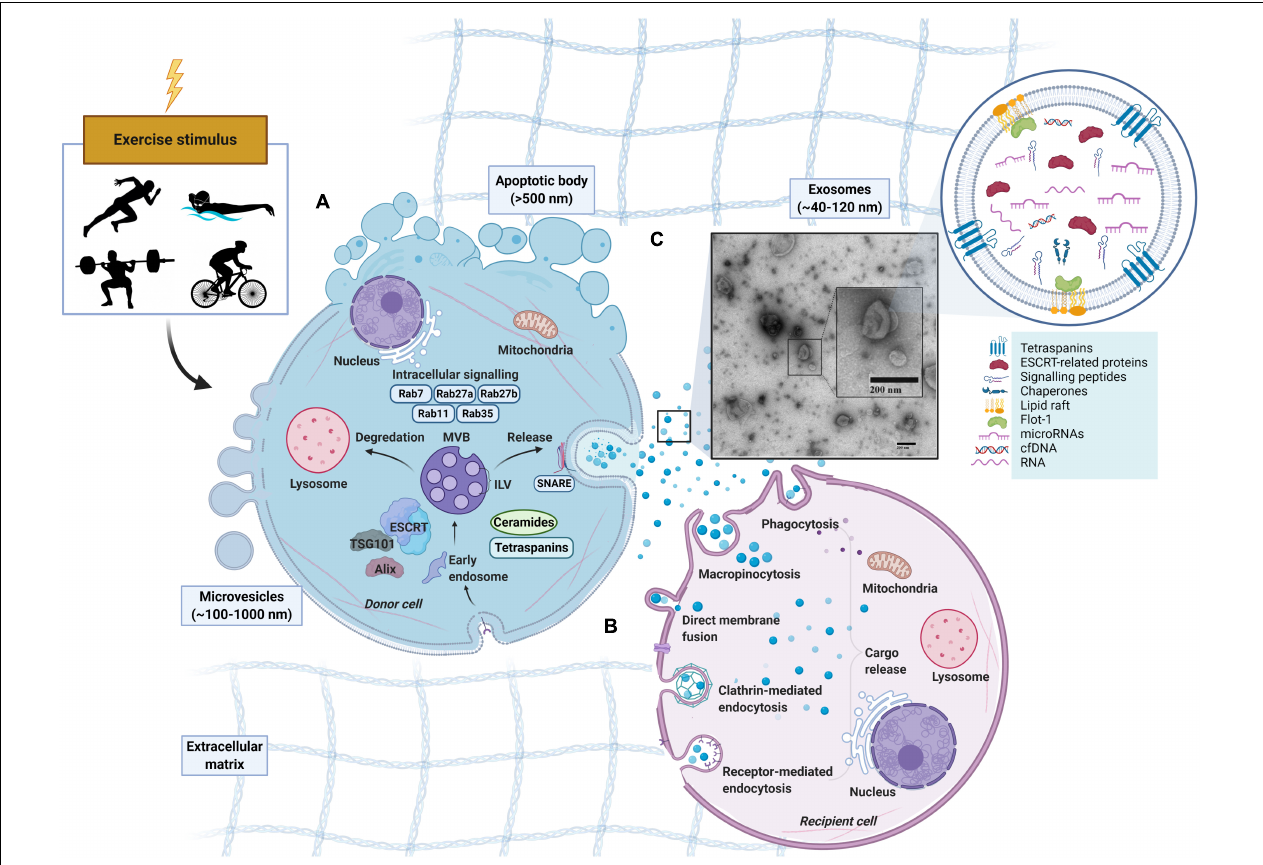
FIGURE 1 | Schematic representation of extracellular vesicles released by cells in response to exercise. Apoptotic bodies ( ∼ > 500 nm), microvesicles ( ∼ 100–1,000 nm) and exosomes ( ∼ 40–120 nm). (A) Exosome formation. Early endosomes form from the inward budding of the plasma membrane (PM) before maturing into late endosomes which contain multiple intraluminal vesicles (ILVs). With the presence of ILVs, the late endosome can also be characterized as a multivesicular body (MVB) (Sotelo and Porter, 1959; Akers et al., 2013). MVBs exist in different subpopulations (White et al., 2006) can either fuse with a lysosome for degradation, or fuse with the PM to release ILVs into the extracellular space as exosomes (Akers et al., 2013; Crenshaw et al., 2018). MVB development in an Endosomal Sorting Complex Required for Transport (ESCRT)-dependent or independent manner with tetraspanins (Hemler, 2005; Pols and Klumperman, 2009) or ceramides (Trajkovic et al., 2008) being involved. Rab GTPases (RABs) and soluble N -ethylmaleimide sensitive factor attachment protein receptors (SNAREs) may also regulate the cargo sorting and transport of exosomes. (B) Exosome uptake in recipient cell. Following release, exosomes can be taken up by recipient cells by direct binding to plasma membrane or engulfment (French et al., 2017). The uptake of exosomes and EVs can be through several avenues including endocytosis (via phagocytosis, micropinocytosis, clathrin-, caveolin-, and/or receptor-mediated endocytosis) or fusing directing to the plasma membrane of the recipient cell